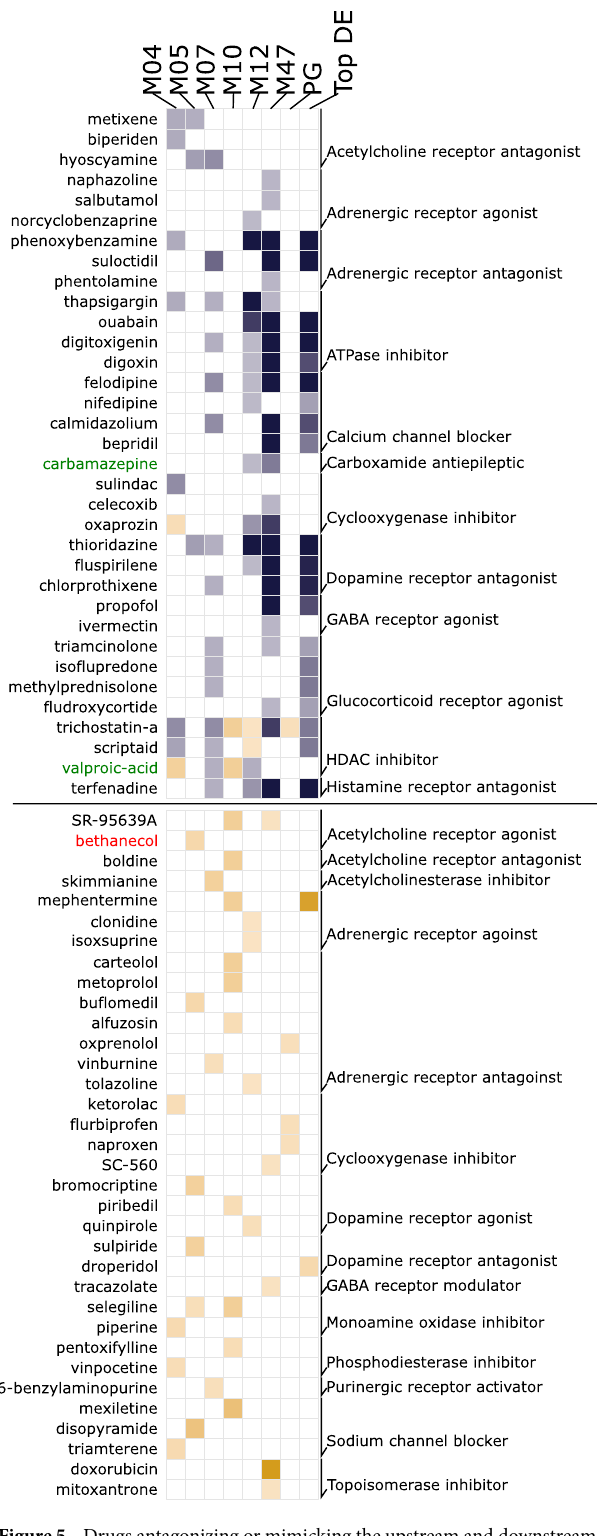
Figure 5. Drugs antagonizing or mimicking the upstream and downstream nodes associated with gene expression profiles. Gene sets of nodes (WGCNA modules) directly connected to source and sink nodes (M04, M05, M07, M10, M12, and M47), predictive gene lists, and top differentially expressed genes (Top DEGs) were used to probe drug-associated signatures from the connectivity map database. Note that known antiepileptic (Carbamazepine and Valproic acid, in green) and epilepsy-inducing (bethanecol, in red) drugs are enriched in nodes directly connected to source and sink nodes, but not in the predictive or top differentially expressed genes. Blue: therapeutic drugs; orange: pro-disease drugs. The − log 10 of the enrichment q value is plotted. The lighter-to-darker shades of blue and orange represent a lower-to-higher enrichment, respectively. See details in the “Method”s and Tables S7 and